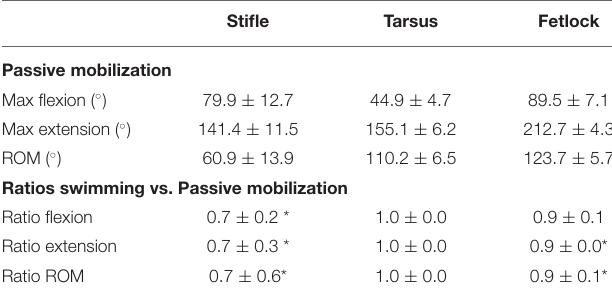
TABLE 3 | Mean ± SD flexion, extension, and ROM comparisons obtained during passive mobilization (PM) and free swimming (n = 9 for tarsus/fetlock; n = 8 for